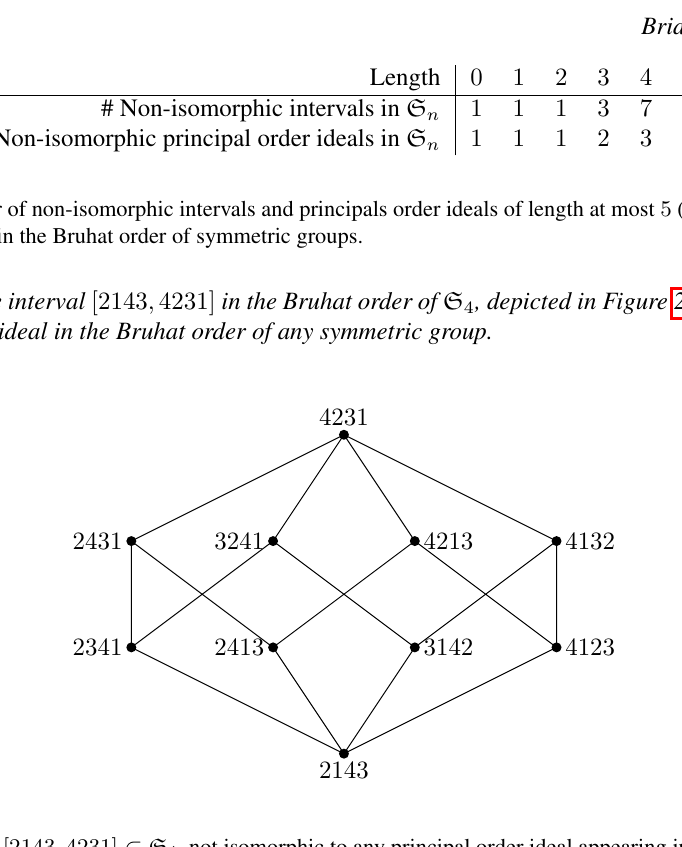
Fig. 2: The interval [2143 , 4231] ⊂ S 4 , not isomorphic to any principal order ideal appearing in the Bruhat order of any S n